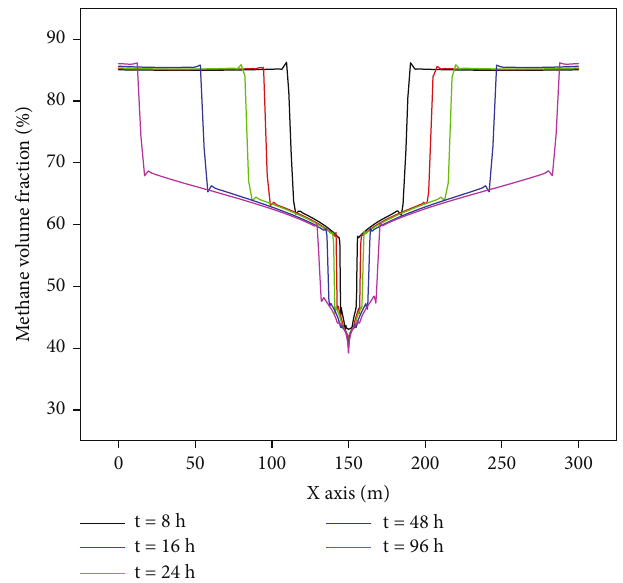
Figure 22: V under water-air alternating displacement along line L. CH 4